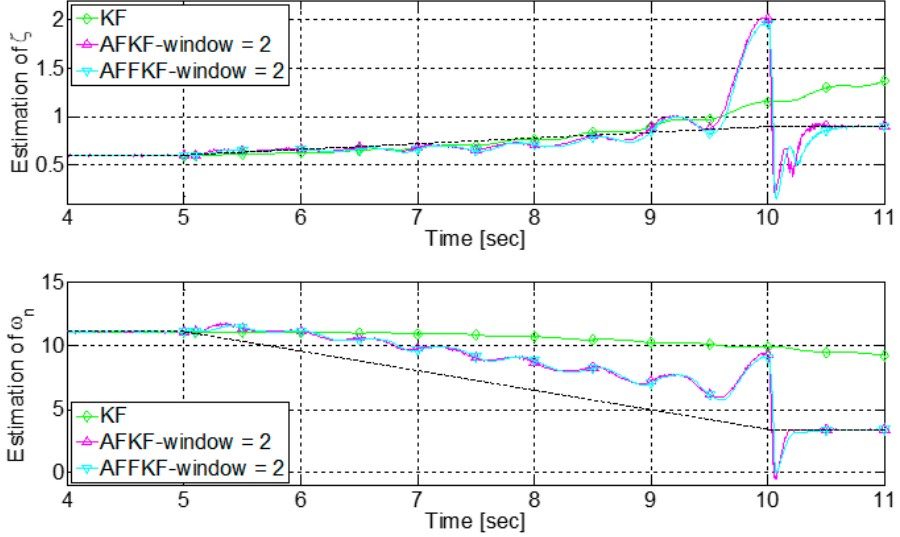
Figure 6. Results of estimation of incipient fault parameter for linear system. Table 4. Comparison of performance index for estimation of incipient fault parameter.